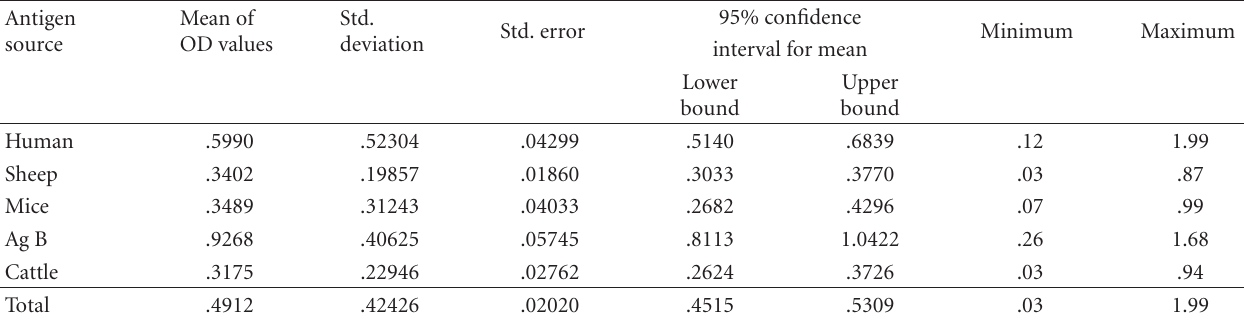
Table 7: Mean, Standard deviation, confidence interval, and the range of total IgG response of 30 naturally infected human sera against di ff erent antigens.